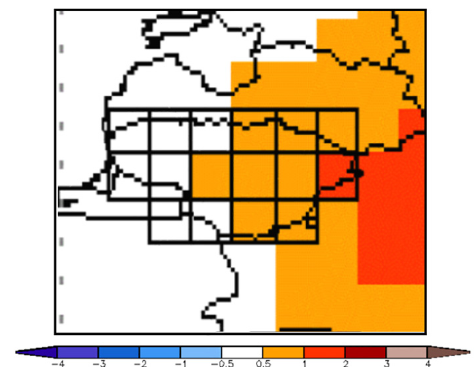
Figure 2. CFSv2 model cells which represent the territory of Lithuania and example of forecast temperature anomalies